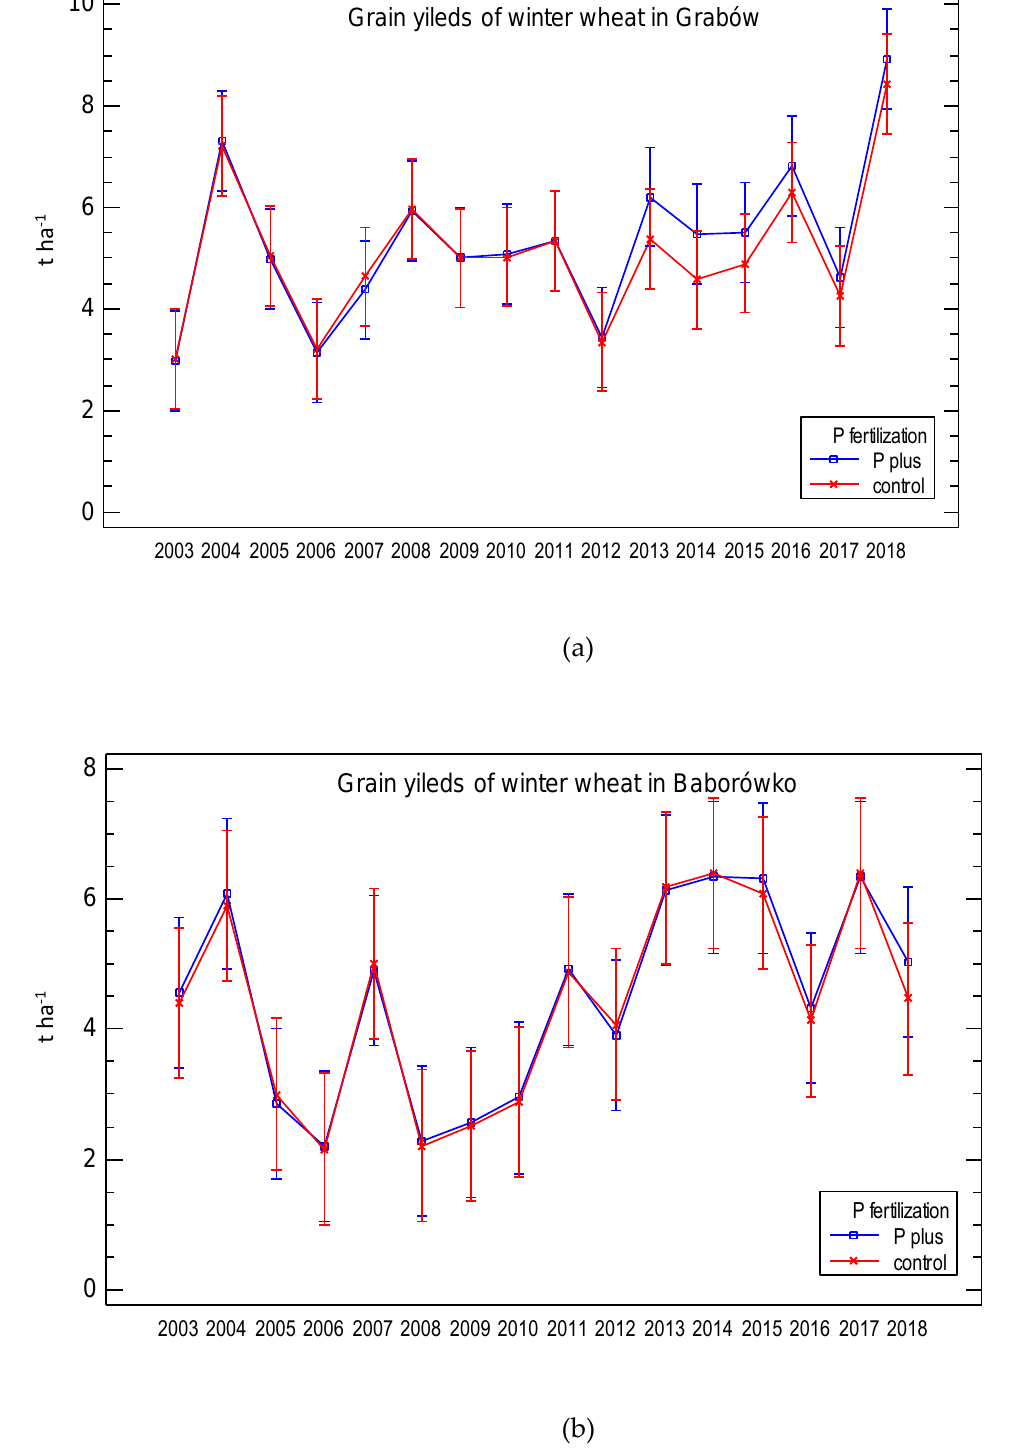
Figure 2. Grain yields of winter wheat in ( a ) Grabów and ( b ) Baborówko; 95% Tukey HSD intervals; n = 384 for each location.